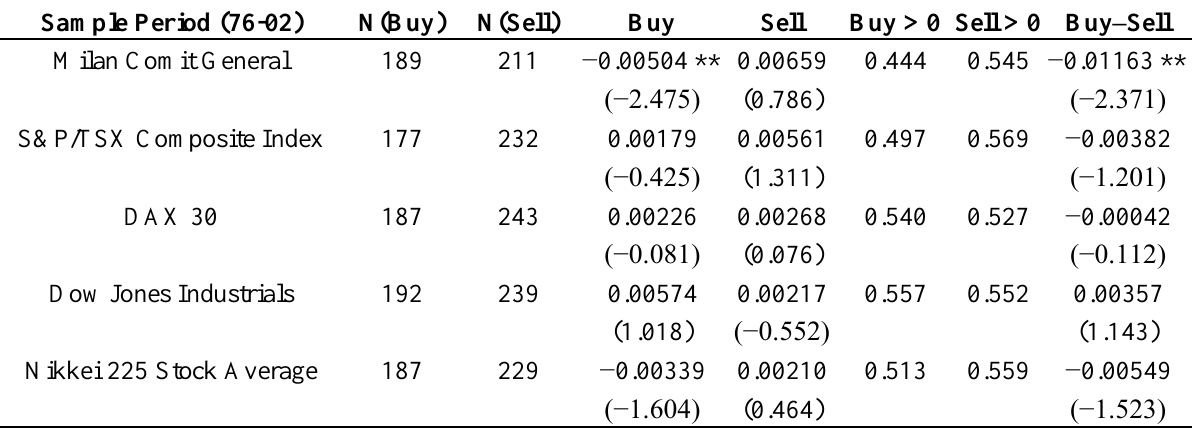
Table 3D. Average ten-day returns from RSI (7,